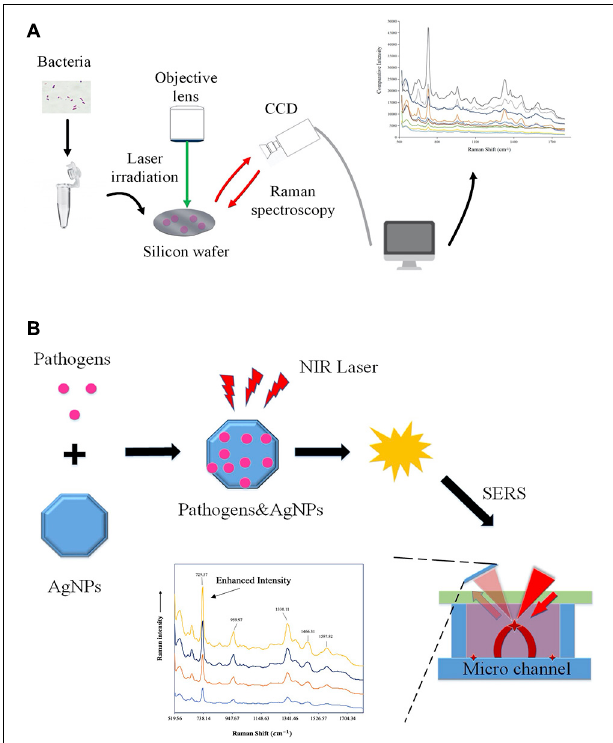
FIGURE 2 | Schematic illustration of the workflow of Raman spectroscopy and surface-enhanced Raman spectroscopy (SERS). (A) Workflow of Raman spectroscopy obtaining information on molecular structure via molecular vibrations and rotations for bacterial classification and antibiotic resistance profiling. (B) Procedures of the surface-enhanced Raman spectroscopy. Samples were measured while being adsorbed on the surface of colloidal metal nanoparticles such as silver (AgNPs), gold, or copper in order to improve signal